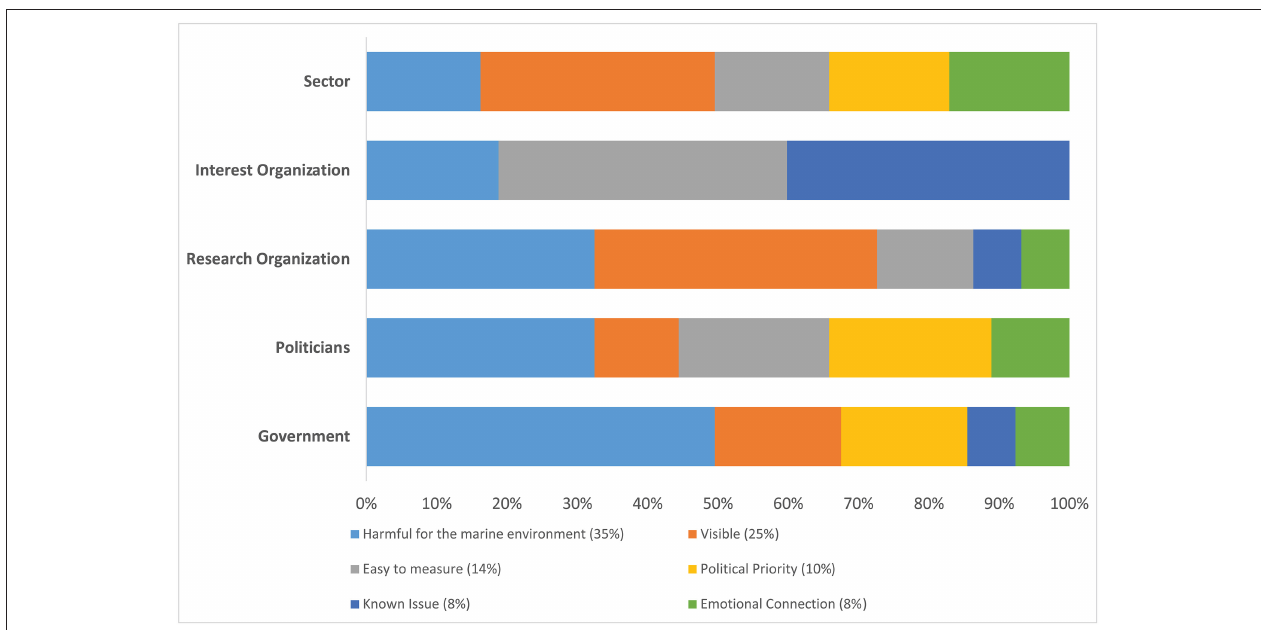
FIGURE 3 | MPs in the marine environment by category of stakeholder. Percentages reported represent the frequency with which an issue was mentioned across all stakeholders responding ( n = 46).